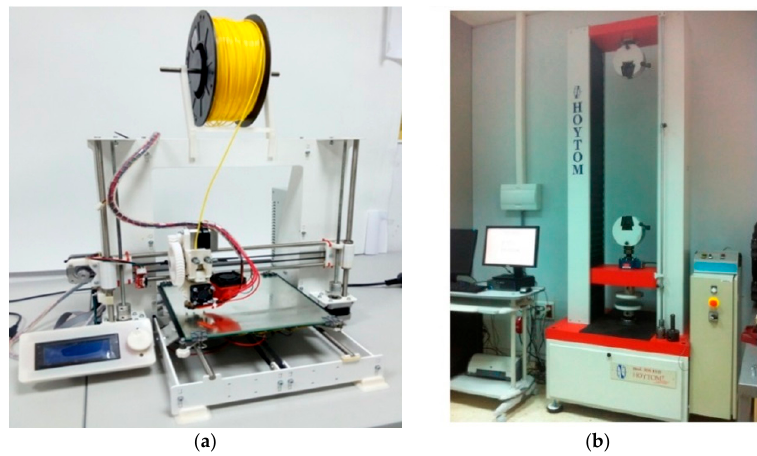
Figure 2. The equipment: ( a ) a Prusa i3 printer; ( b ) a HOYTOM HM-D 100kN Universal testing Figure machine.